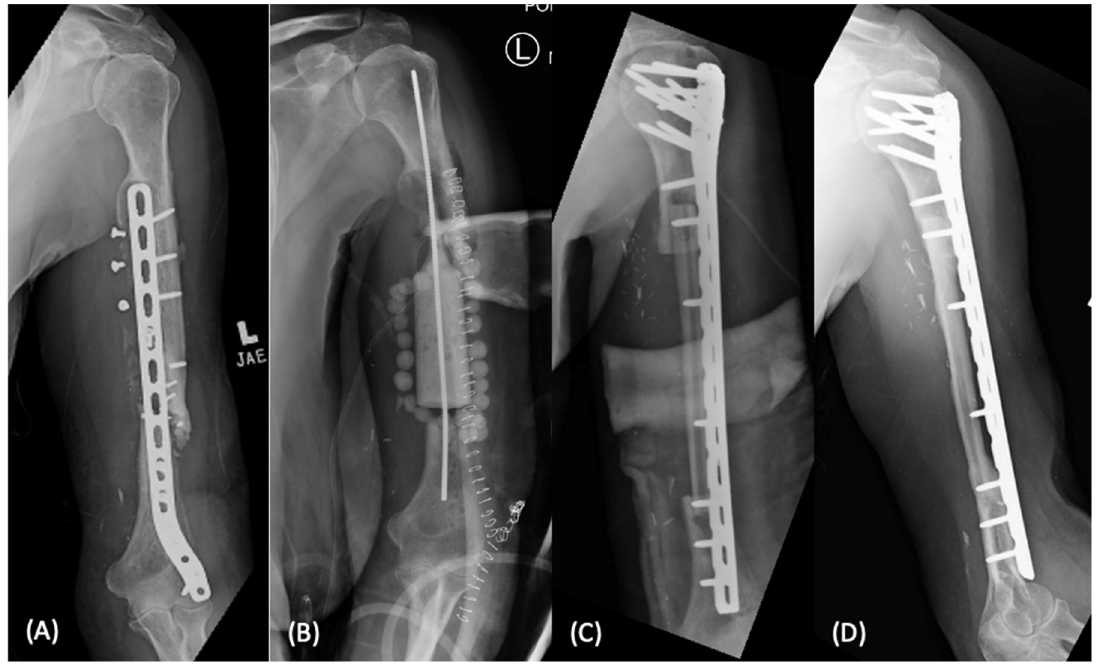
Figure 3. Management of infected humeral shaft non-union with free vascularized fibula transfer (arrow) ( A ). Initially treated with removal of hardware, debridement, and temporary antibiotic cement spacer ( B ). Subsequently, the patient underwent vascularized free fibula transfer and revision open reduction internal fixation ( C ), with excellent graft incorporation at one-year follow up ( D ).